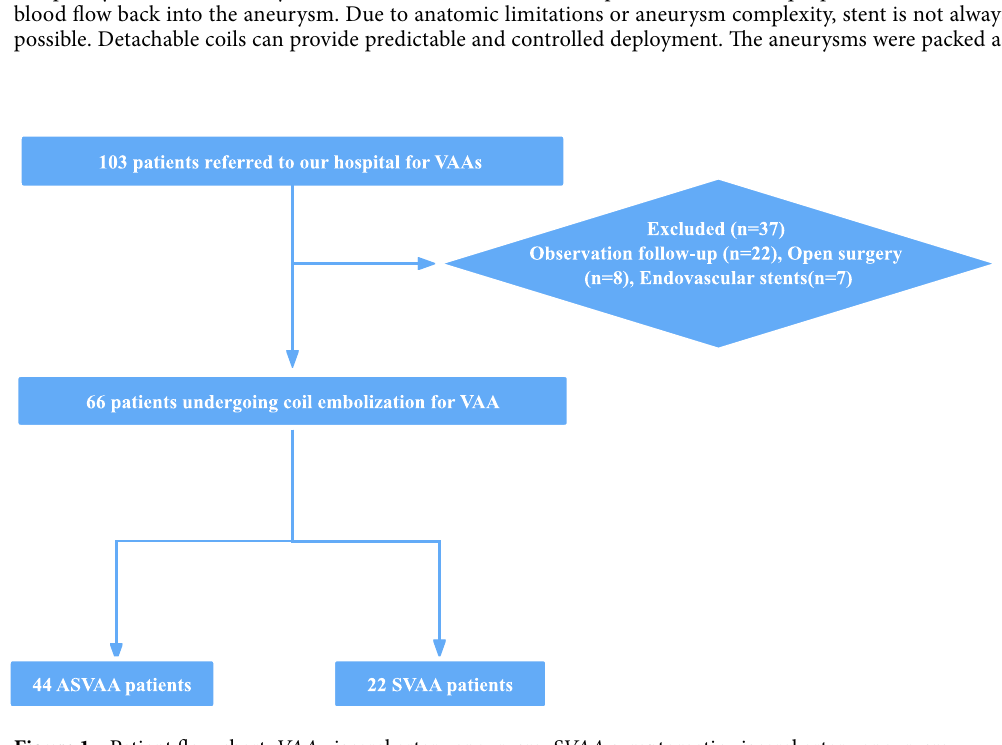
Figure 1. Patient flow chart. VAA visceral artery aneurysm, SVAA symptomatic visceral artery aneurysm, ASVAA asymptomatic visceral artery